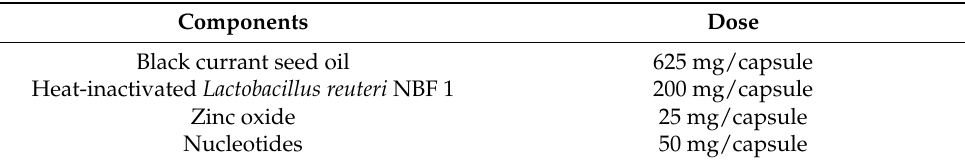
Table 2. Ribes Pet Symbio composition.